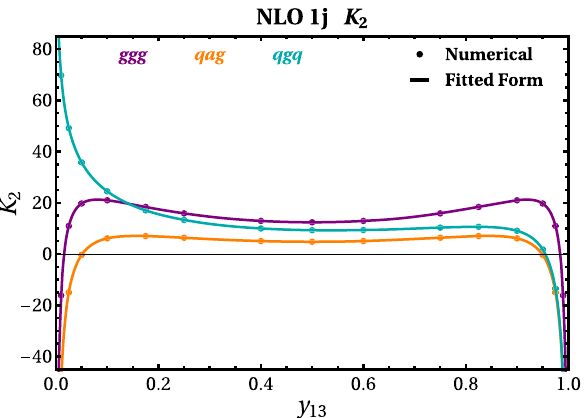
Fig. 2 Numerical results for the 1-jettiness soft function at NLO for the partonic channels gg → g , q ¯ q → g , and qg → q . We plot the O ((cid:9) 2 ) coefficient of the (cid:9) -expansion of the soft function as a function of y 13 ∈ [ 0 , 1 ] . Included (but not visible) in the plot are the fitting uncertainties at the 95% confidence